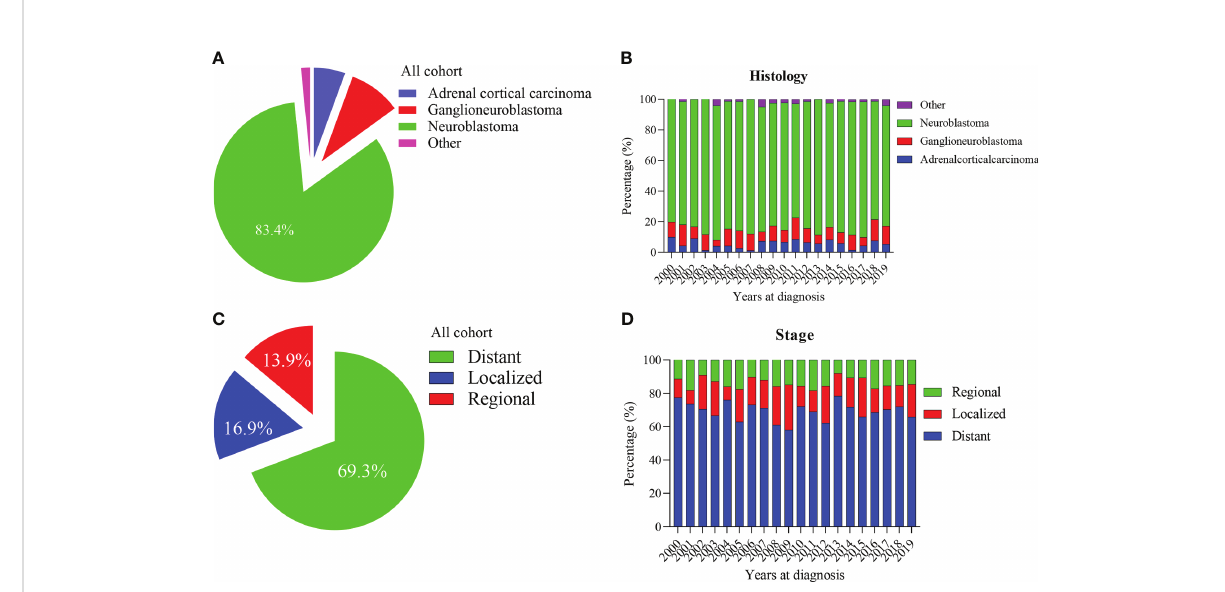
FIGURE 1 Percentage of pediatric adrenal malignancies by histology and tumor stage. (A, B) Percentage of histology in all cohorts and strati fi ed by year at diagnosis. (C, D) Percentage of tumor stage in all cohorts and strati fi ed by year at